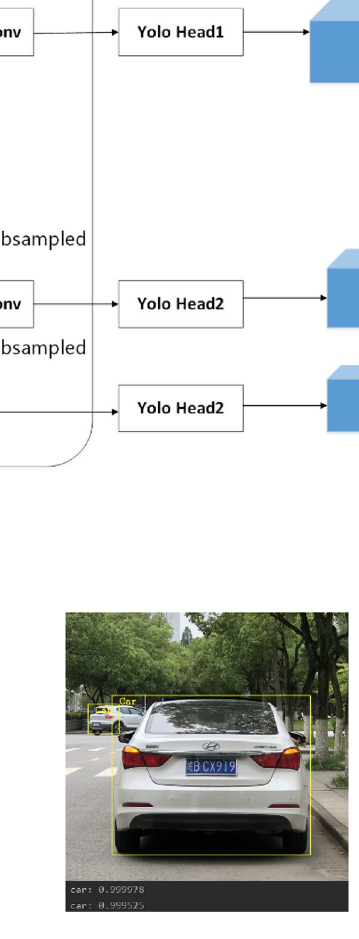
Fig. 3 YOLOv4 vehicle tail detection